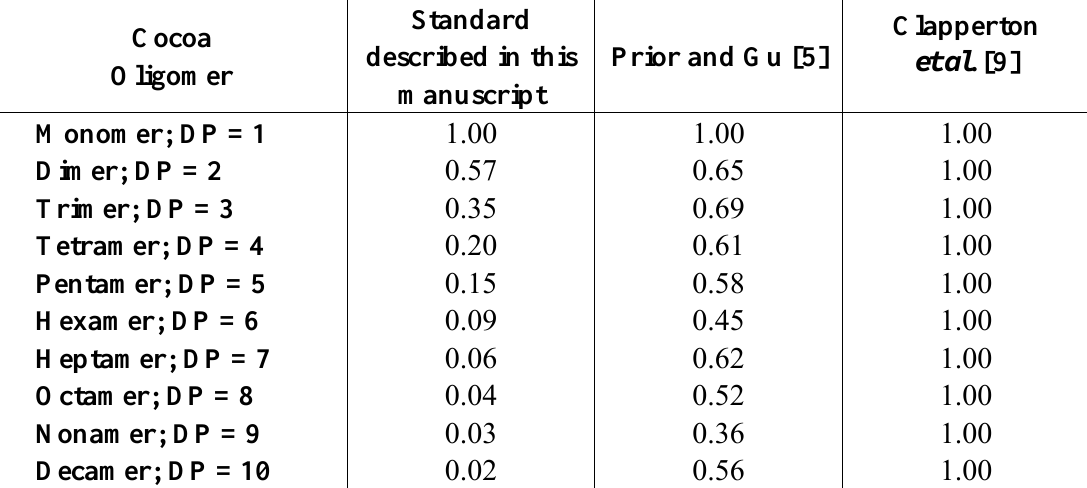
Table 3. Chromatographic response factors for